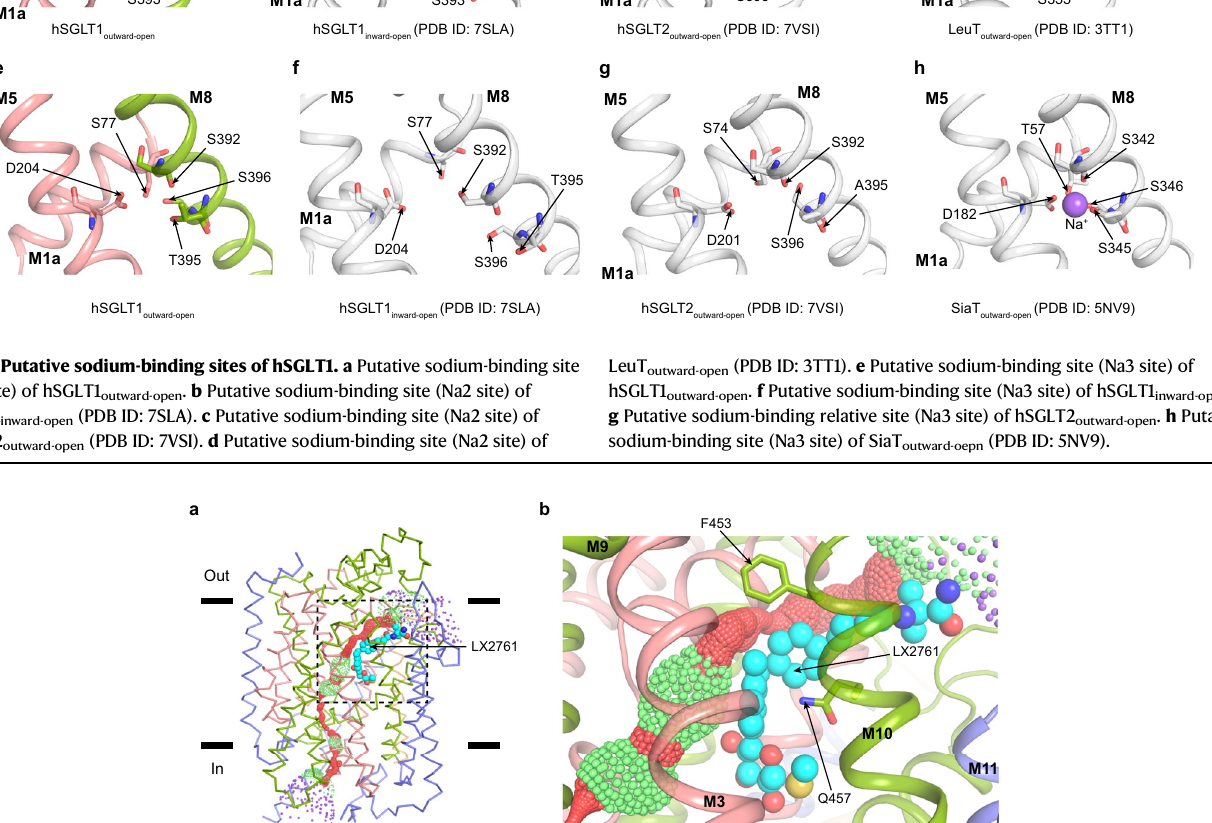
red, green and purple, respectively. LX2761 is shown as cyan spheres. b LX2761 blockswaterpermeationatthe extracellularvestibule(boxed in a ).Residues along the water permeation pathway are shown as sticks.